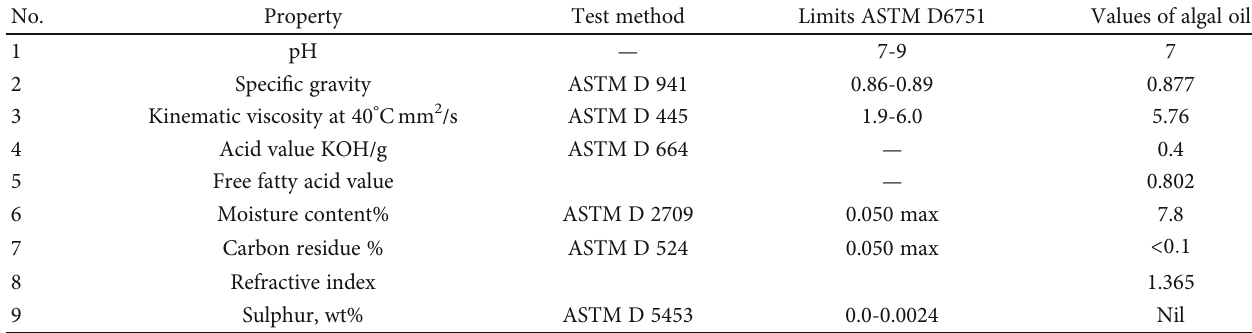
Table 3: Physicochemical properties of Spirulina microalgae oil.